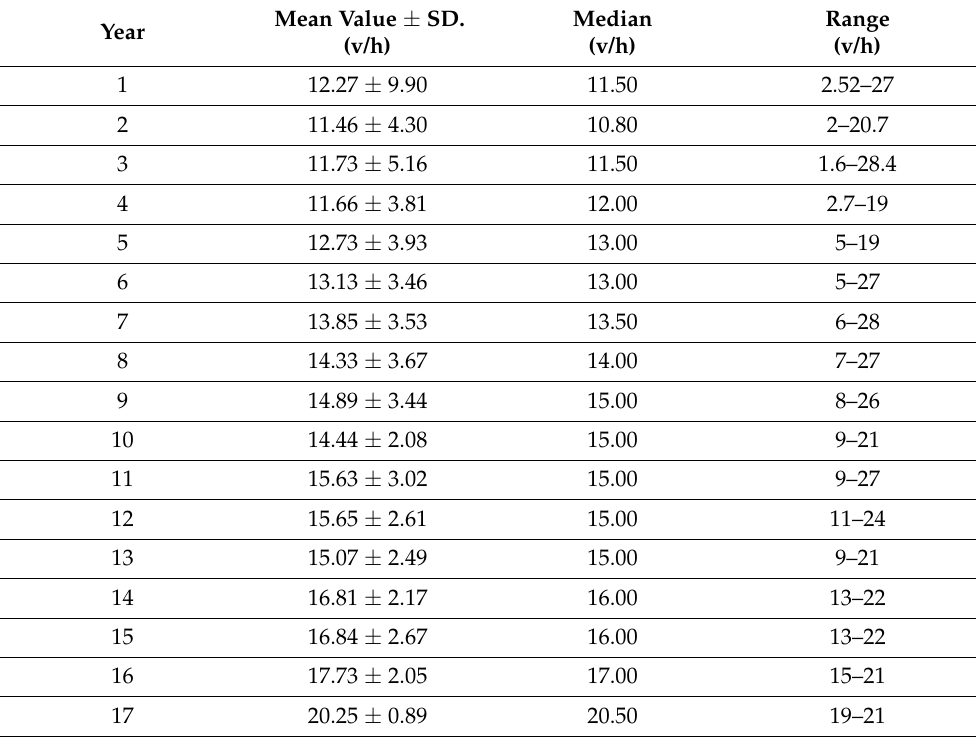
Table 3. Mean and median air exchange values (v/h) per year of